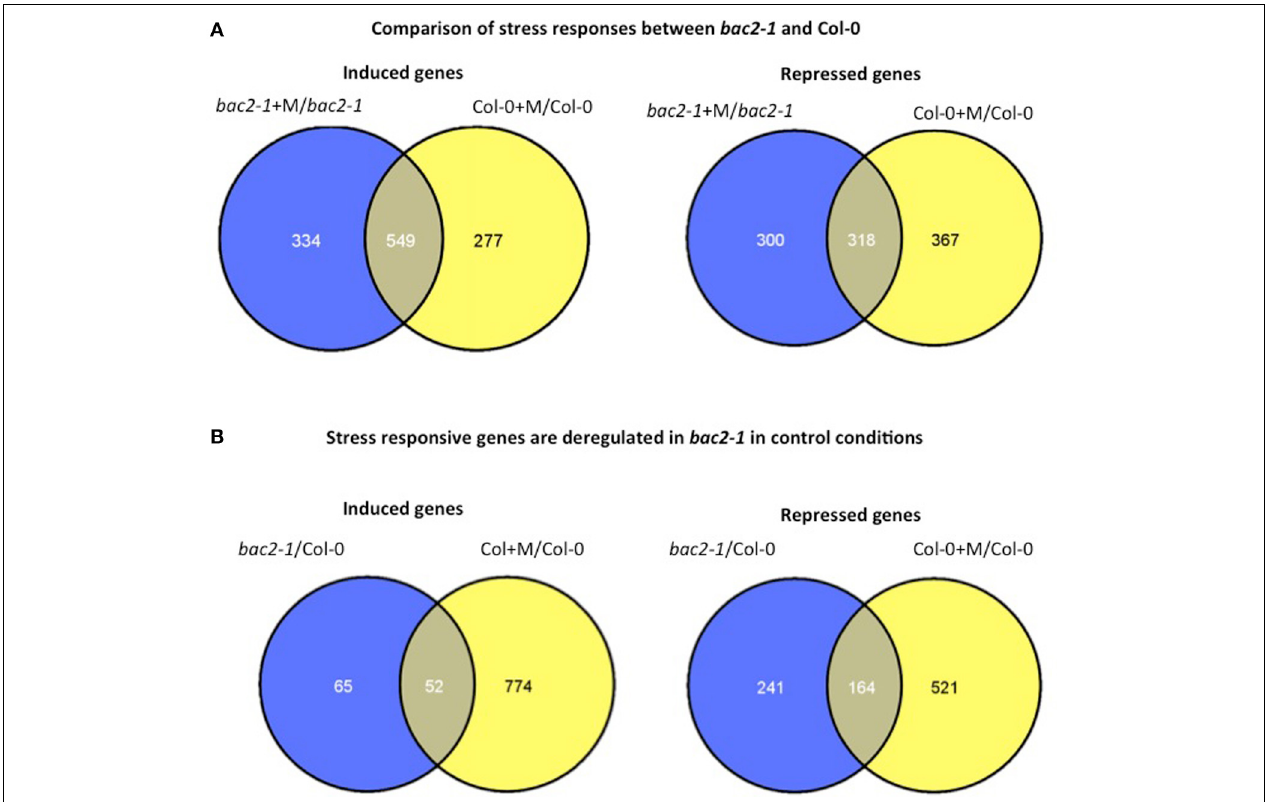
FIGURE 5 | Comparison of gene expression in bac2-1 and Col-0 plantlets. (A) Venn diagram of differentially expressed genes in bac2-1 and Col-0 after water stress ( + M) including induced genes or repressed genes. (B) Venn diagram of differentially expressed genes in bac2-1 without stress and Col-0